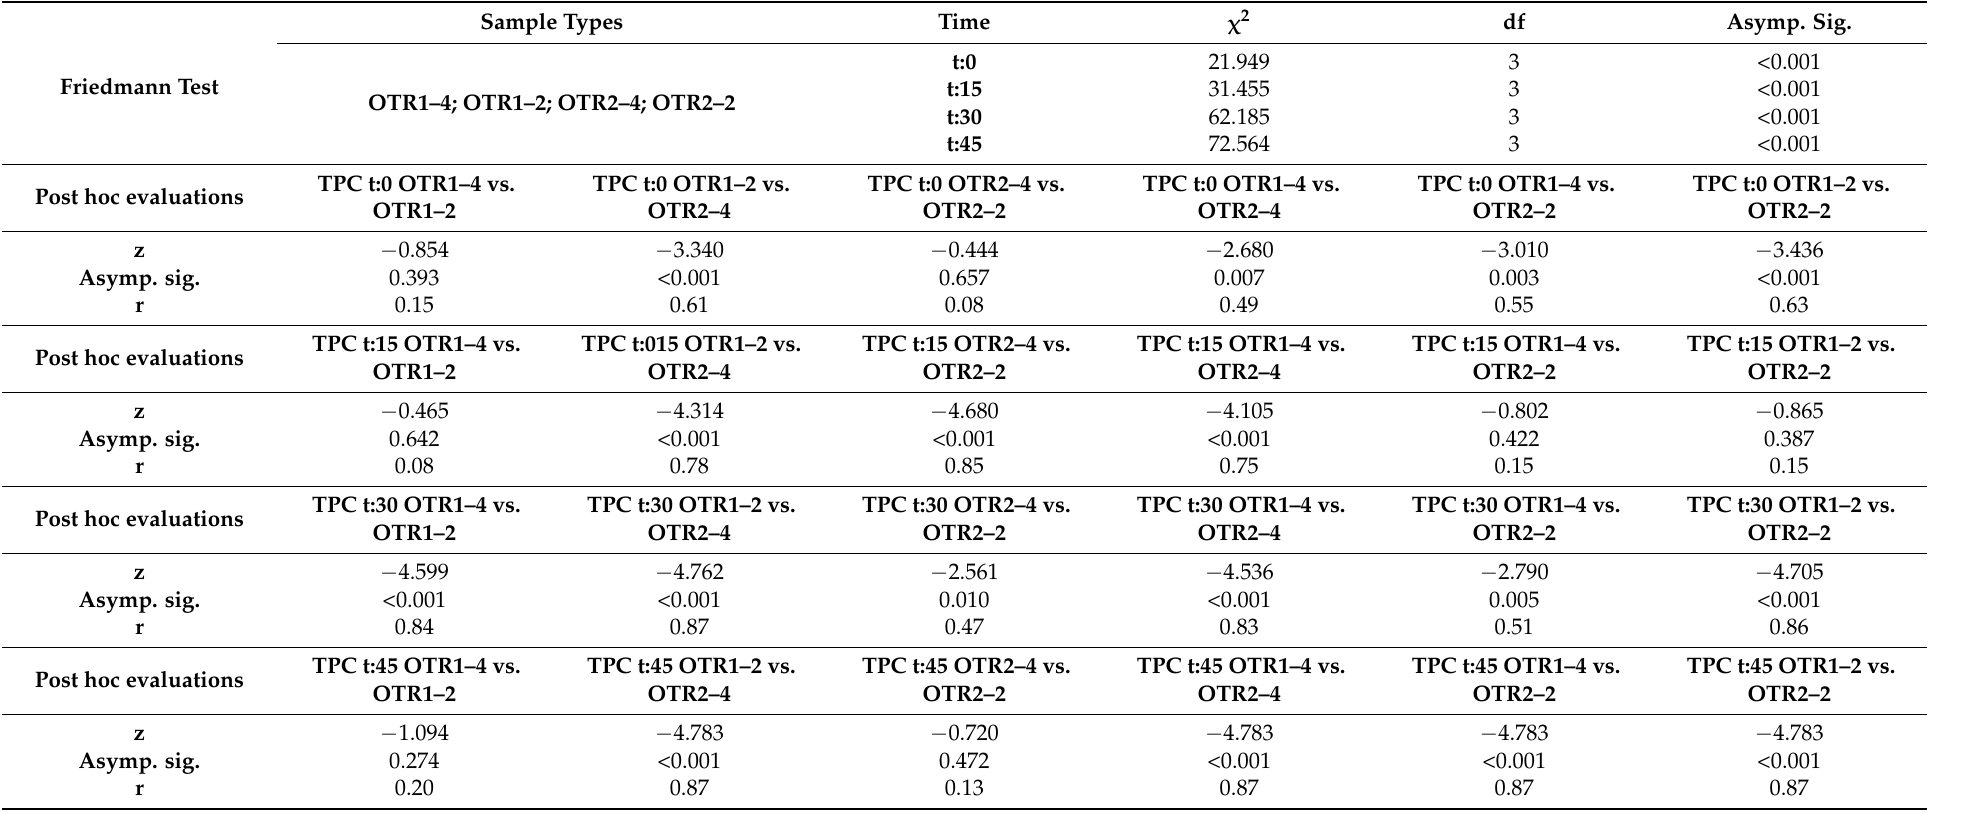
Table 8. Statistical results and respective post hoc inferences concerning TPC values and OTR1–2